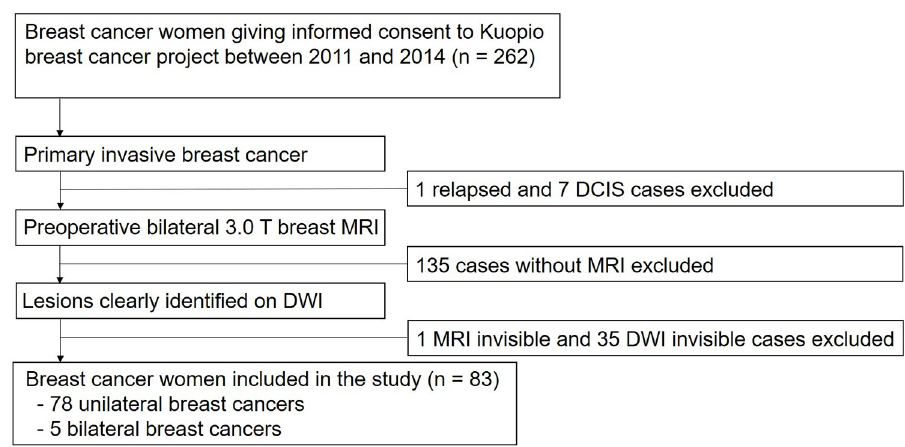
Fig 1. Flowchart of the study population. DCIS = ductal carcinoma in situ, DWI = diffusion-weighted imaging.